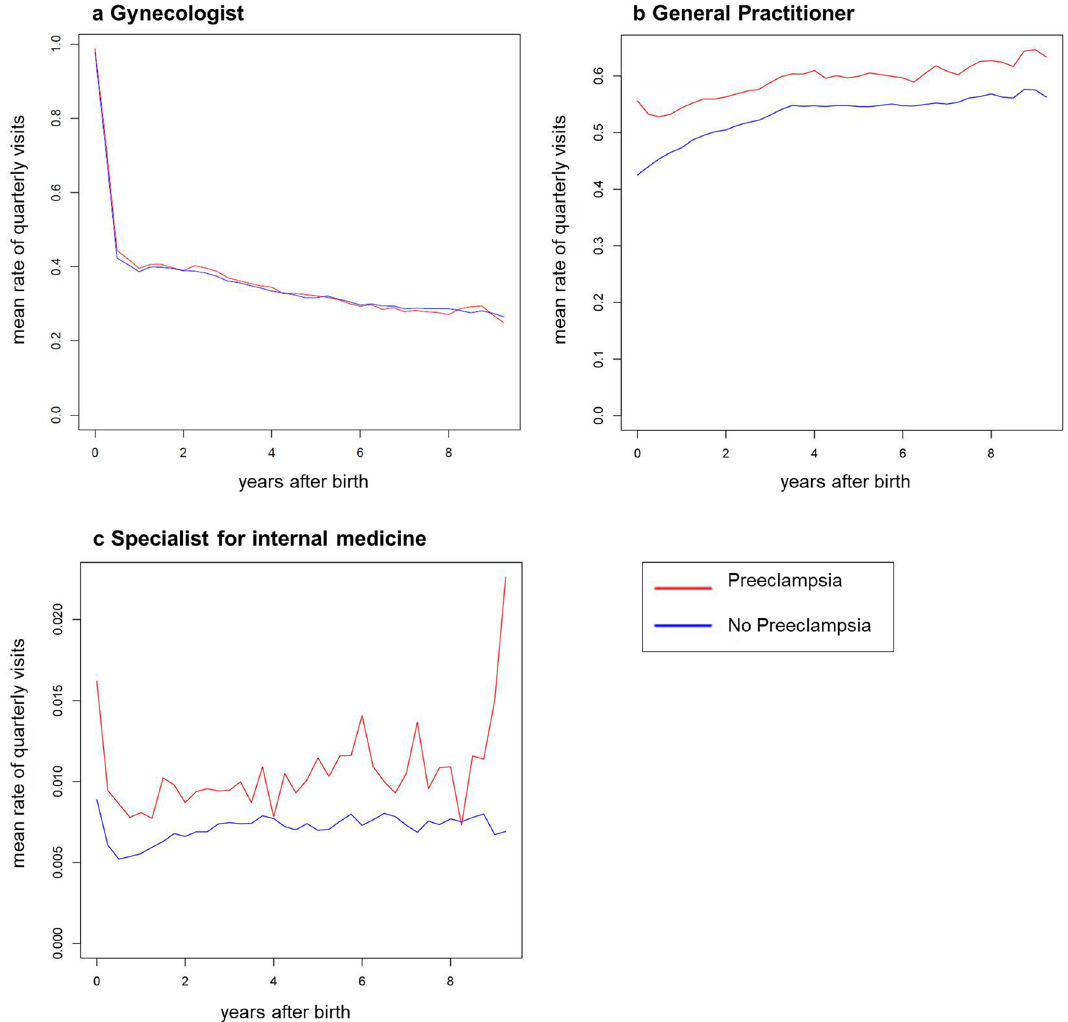
Figure 1. Postpartum care utilization in patients with and without PE. Mean rates of quarterly visits to the gynecologist ( a ), general practitioner ( b ), and specialist for internal medicine ( c ) in patients with (red) and without PE (blue) after